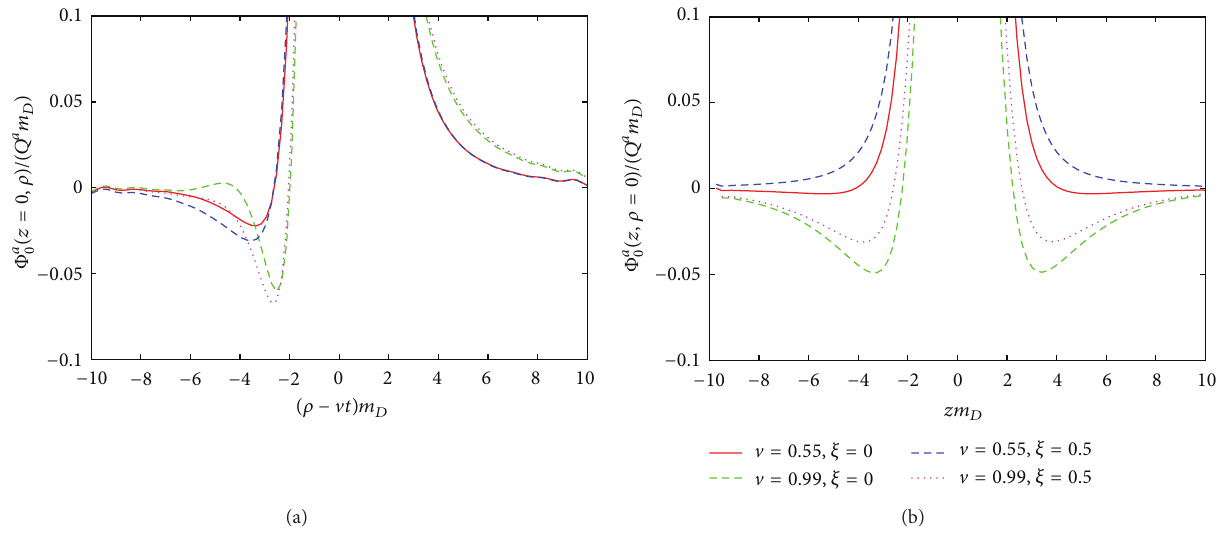
Figure 13: (Color online) The left (right) panel shows scaled wake potential for 𝜉 = {0,0.5} with parton velocity V = 0.55(0.99) . In this case the parton moves perpendicular to the direction of anisotropy